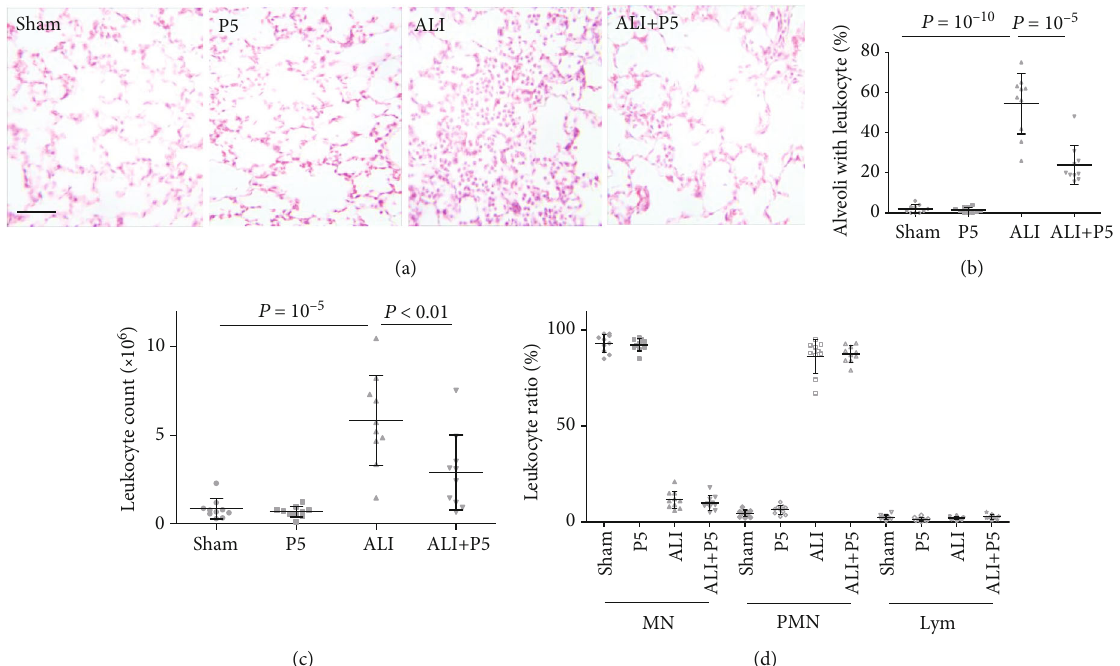
Figure 5: P5 reduced alveolar leukocyte recruitment. (a, b) Saline (Sham) or P5 (8mg/kg, P5) was injected twice though ip at 2 and 16hr post-ALI induction in mice. At 4hr after second administration, mouse lungs were fi xed in situ with PF, cut into 10 μ m sections, and stained with H&E. The counts of alveoli with and without leukocytes were obtained in a double-blind manner. n = 10 , ∗ P < 0 : 05 . (c) Mouse BALF samples were obtained as described in Figure 3(b). Flow cytometry analysis of BALF was performed at Body Fluid mode to obtain total counts of alveolar leukocytes. n = 10 , ∗ P < 0 : 05 . (d) After centrifugation at 1,000g, cell pellets from BALF were resuspended in serum and subjected to Wright-Giemsa staining on a glass slide. The counts of monocyte/macrophage (MN), neutrophil (PMN), and lymphocyte (Lym) and the ratio (%) of each cell type were obtained. N = 10